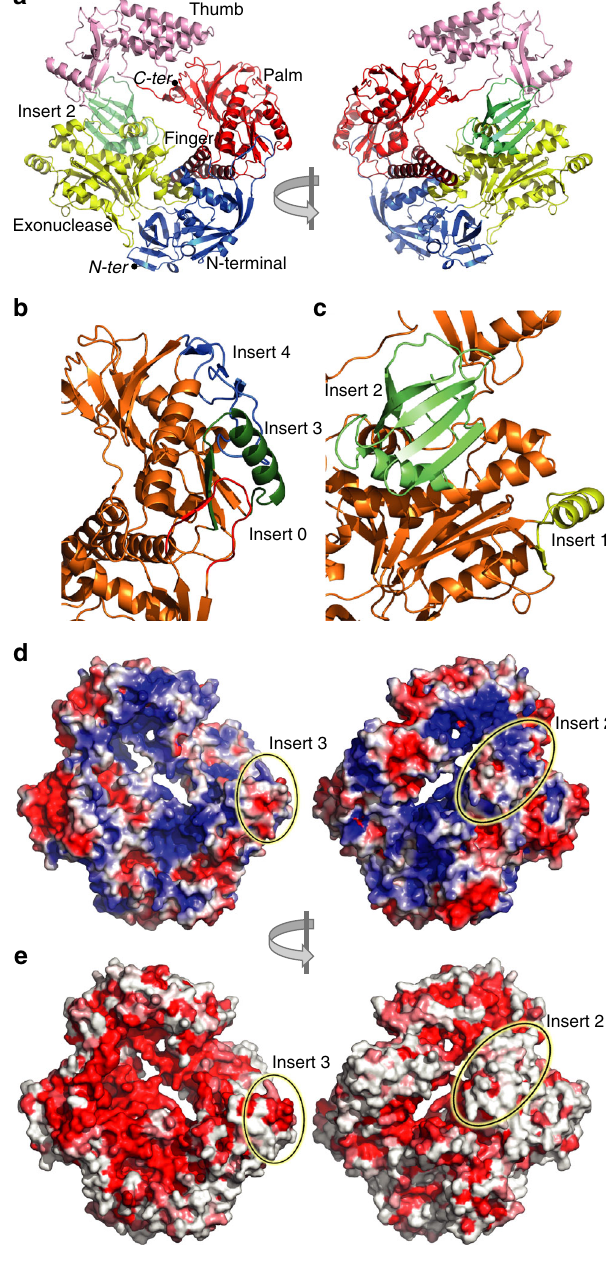
Fig. 1 Domain structure of E9. De fi nitions according to Liu et al. 33 :